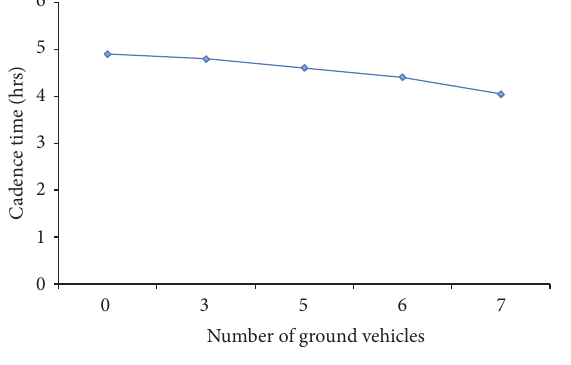
Figure 10: Delivery ratio.